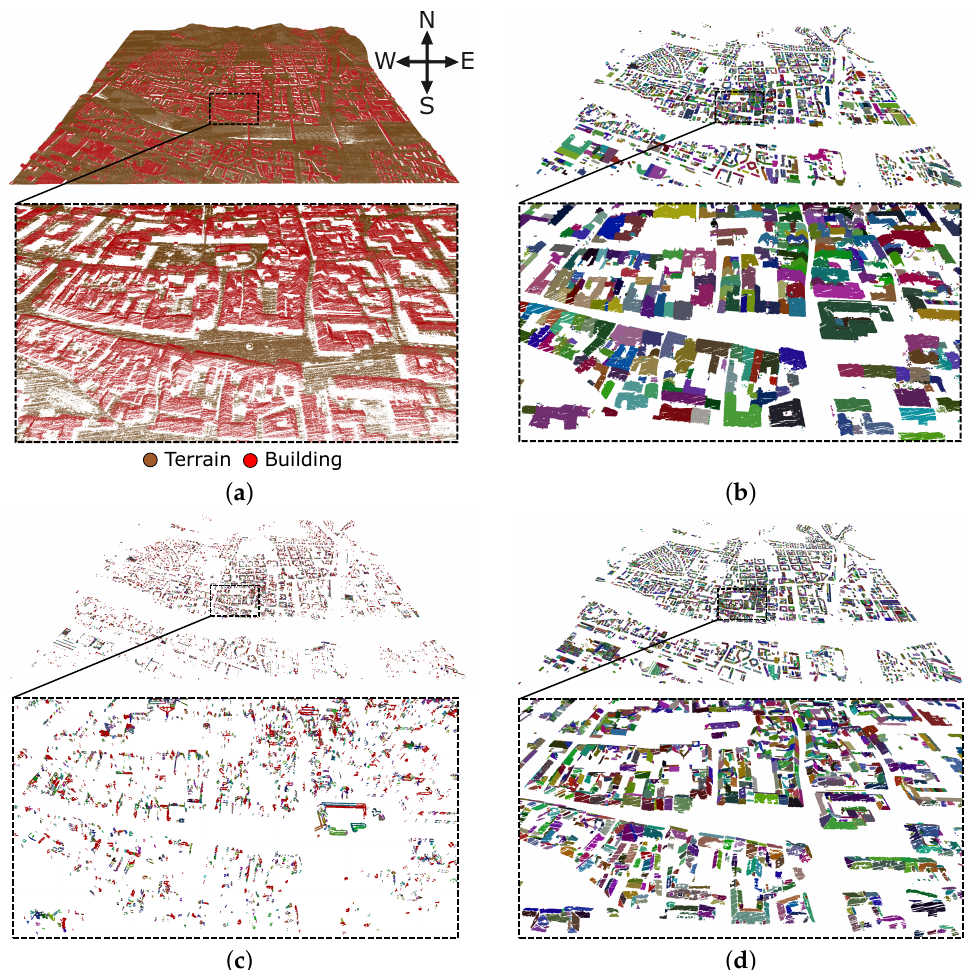
Figure 6. Illustration of input data processing, where ( a ) shows the input LiDAR point cloud acquired over Maribor (Slovenia), ( b ) building point sets obtained with clustering by position, ( c ) detected height jumps and ( d ) segmented planar faces over segments from ( b